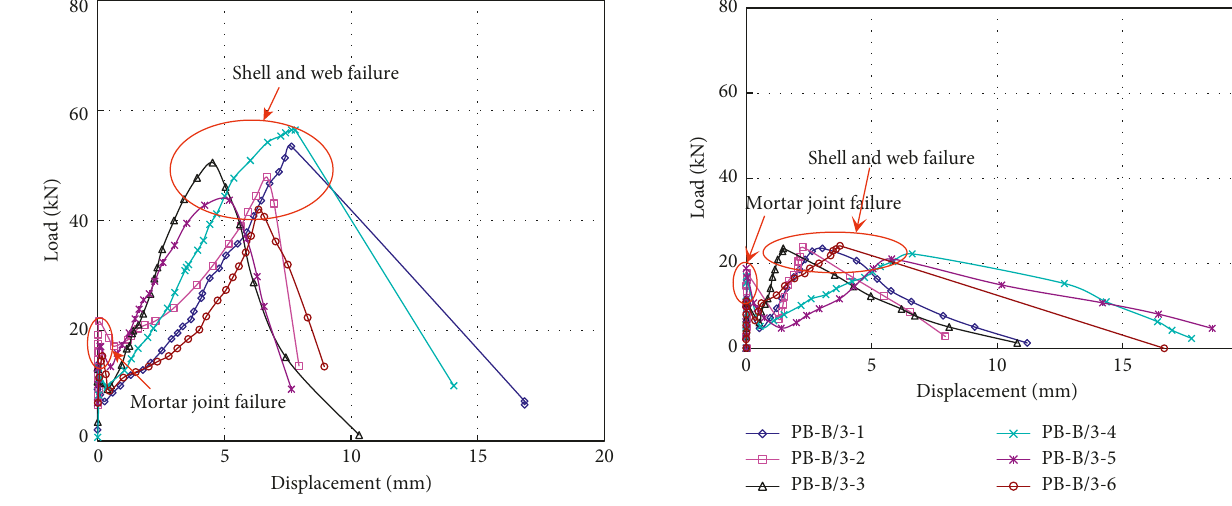
Figure 15: Load-displacement response of group